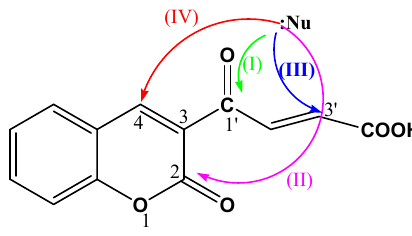
Figure 2. Possible sites of nucleophile attack on coumarin derivatives.